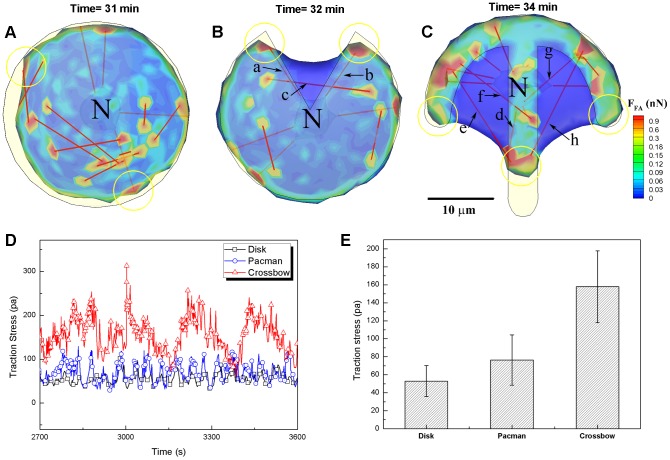
Contour plots of traction (or FA) force on ventral cell surfaces.Spreading cells on three fibronectin coated micropatterns of A) disk, B) pacman and C) crossbow shapes. Plots also reveal distributions of oriented ventral SFs and SFs connected to the nucleus (red lines). N indicates a nucleus and scale bar is 10 µm. D) Temporal variations of total traction stress per a cell on three different micropatterns, and E) time-averaged total traction stress of the cell for one hour is high in the order of the crossbow, pacman and disk shapes.